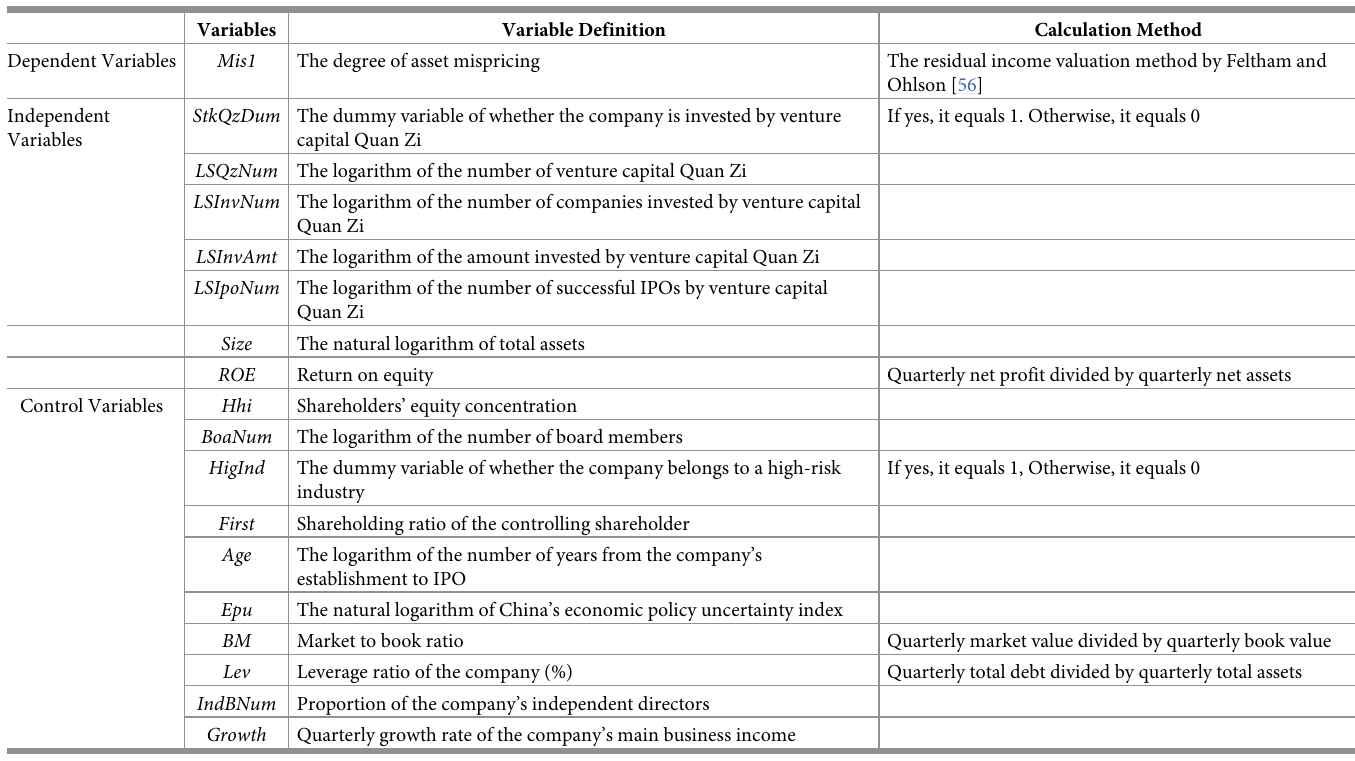
Table 3. Variable